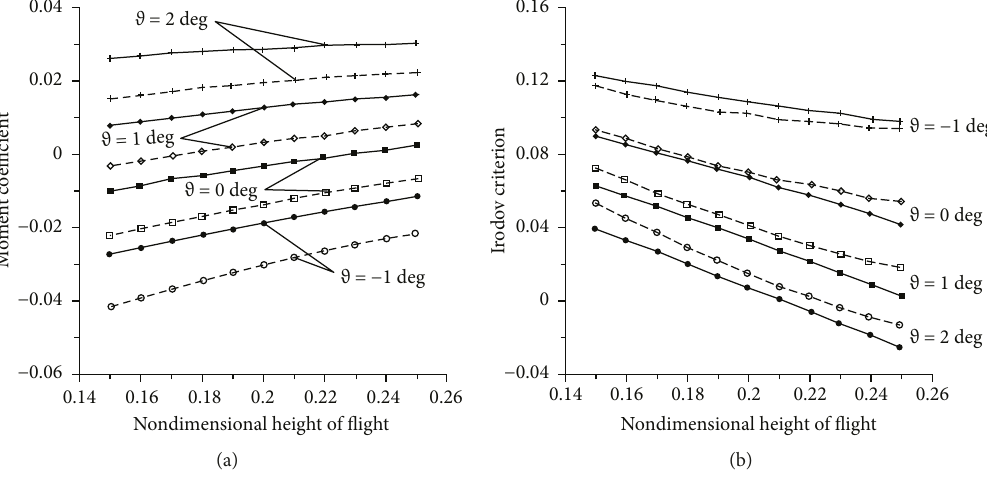
Figure 6: Pitching moment coe ffi cient (a) and the Irodov criterion (b) versus the nondimensional